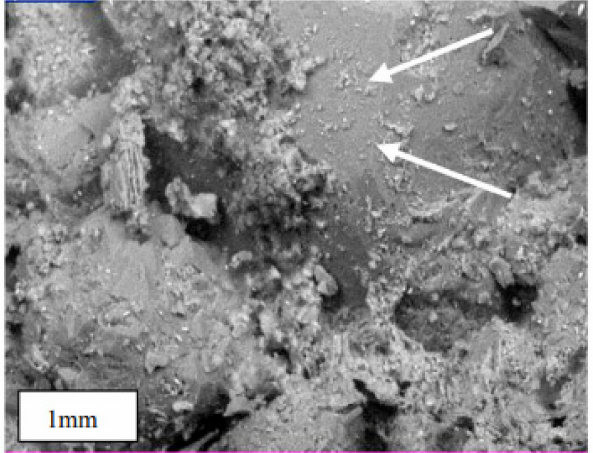
Figure 7. The spread of altered minerals on a sandstone sample post exposure to betaine